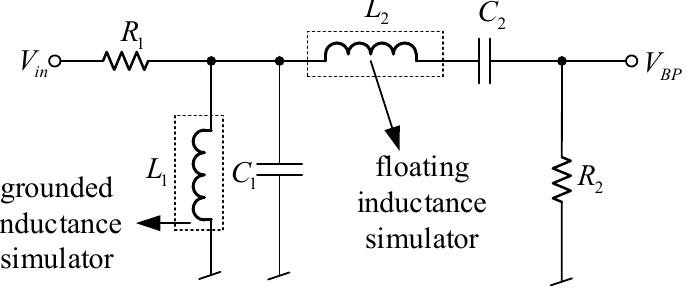
Figure 1. Design of the 4th ladder bandpass filter by replacing the inductance simulators instead of passive inductors [2].